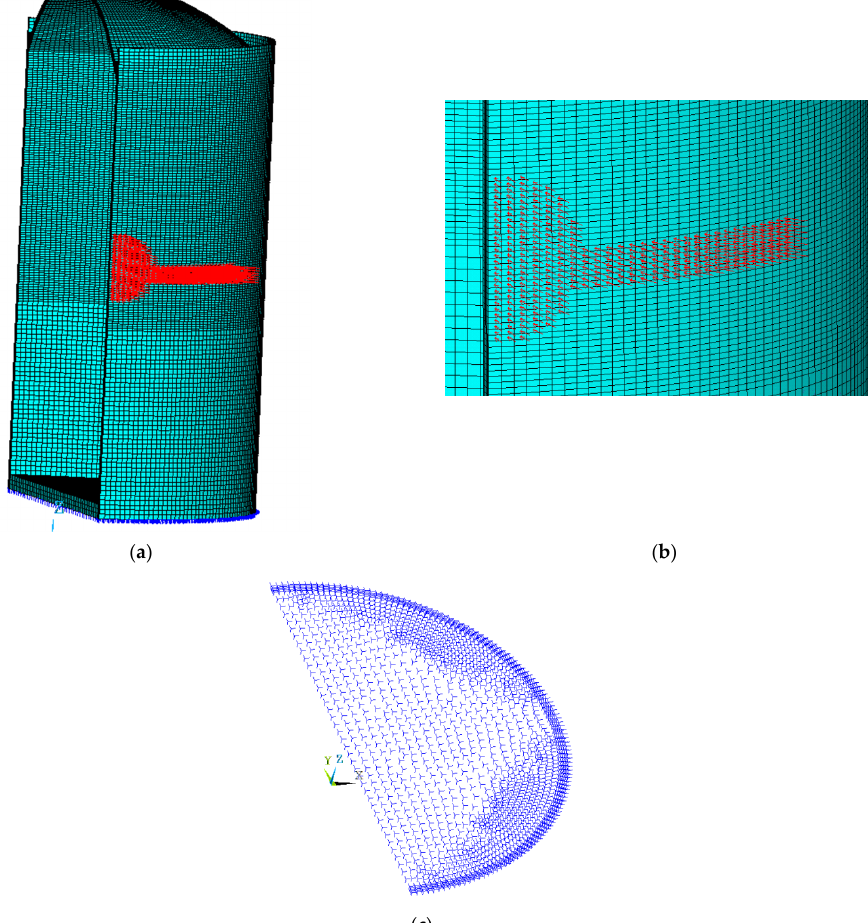
Figure 3. FE model of full SC containment considering the site condition. ( a ) Overall model. ( b ) Load area. ( c ) Distribution of COMBIN 165.